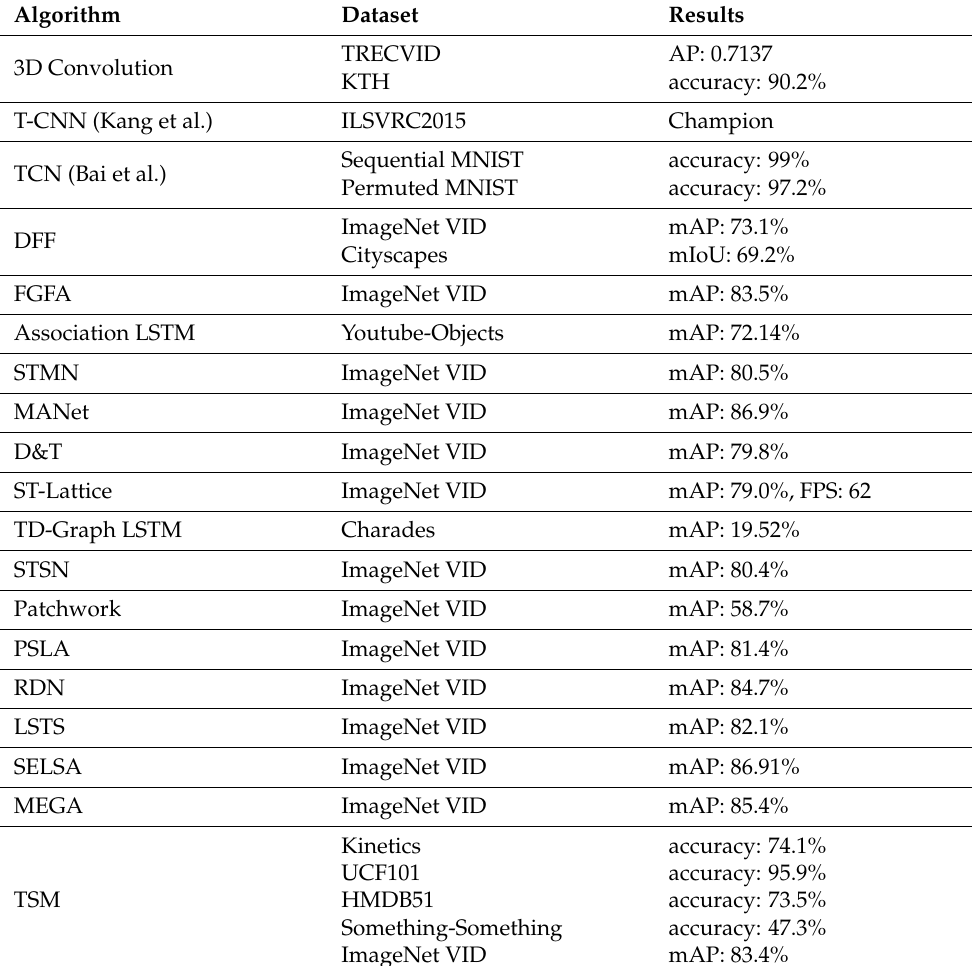
Table 4. The state-of-the-art video detection algorithms, which operate on multiple adjacent frames. ILSVRC denotes the ImageNet Large-Scale Visual Recognition